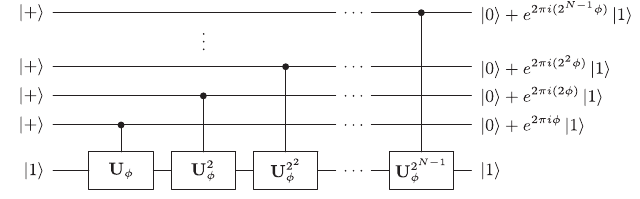
FIG. 5. Quantum phase estimation, controlled phase-gate stage. Figure taken from Ref. [20], but with Hadamards already